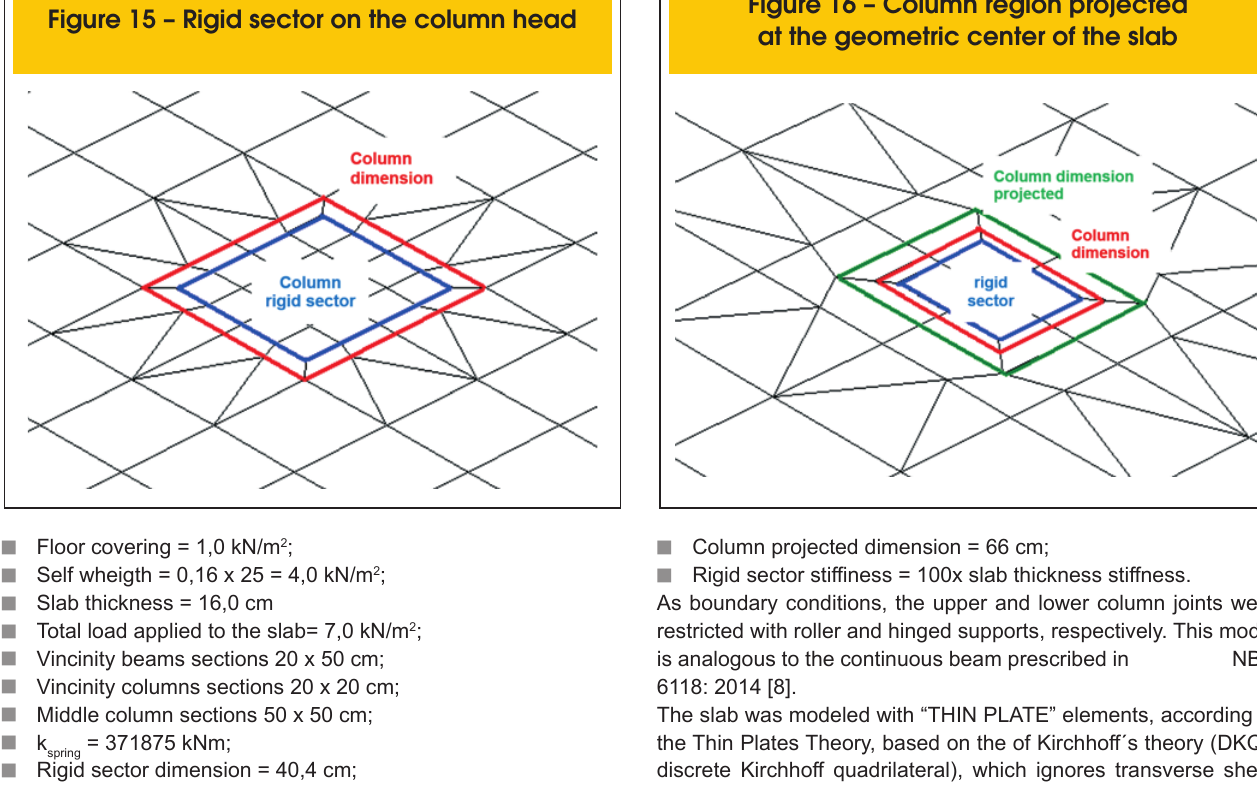
Figure 16 – Column region projected at the geometric center of the